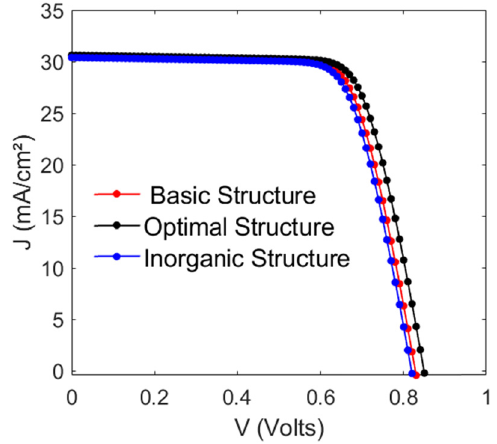
Figure 4: J – V characteristics of CsSnI 3 - based structures.